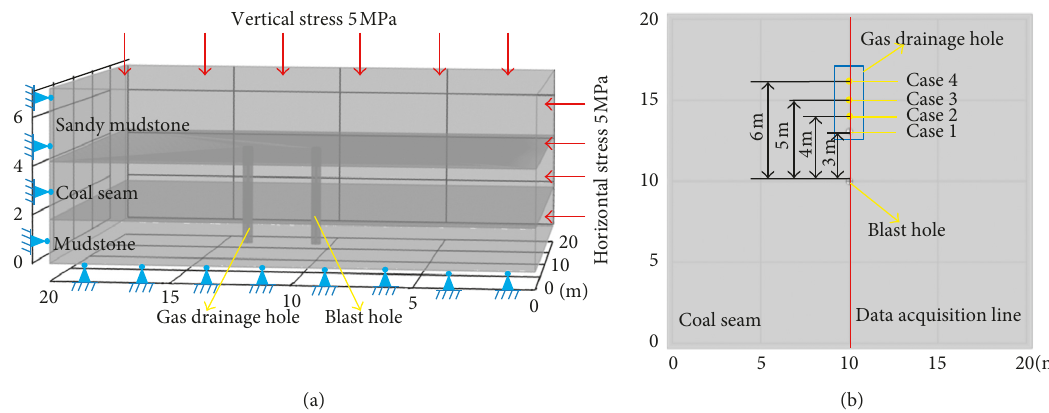
Figure 8: Numerical simulation model: (a) three-dimensional model; (b) top views.